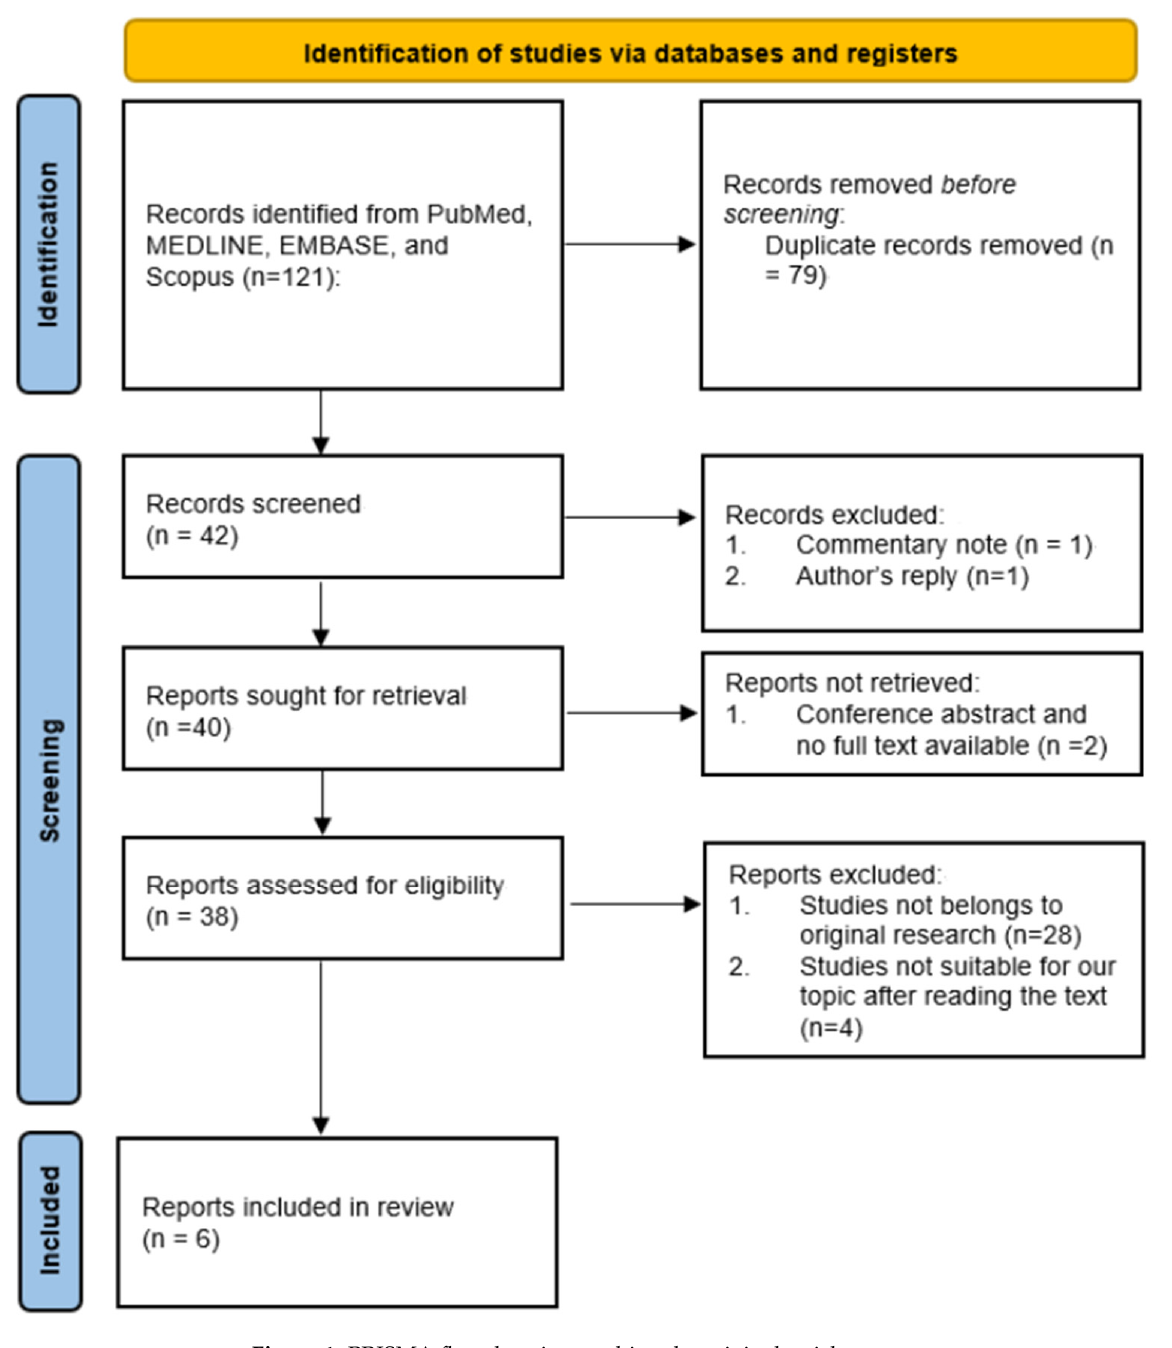
Figure 1. PRISMA flowchart in searching the original articles.